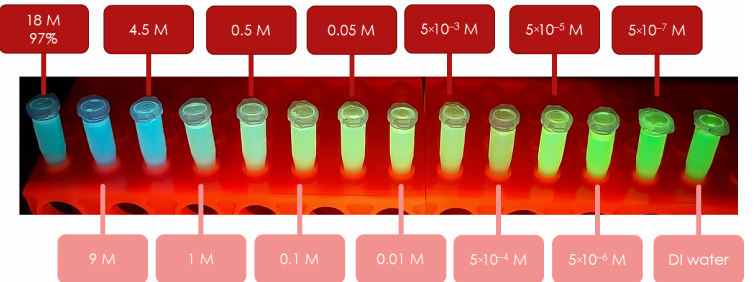
Figure 3. Fluorescein in H 2 SO 4 solutions under an UV-A mercury vapor lamp with the main spectral line at 365